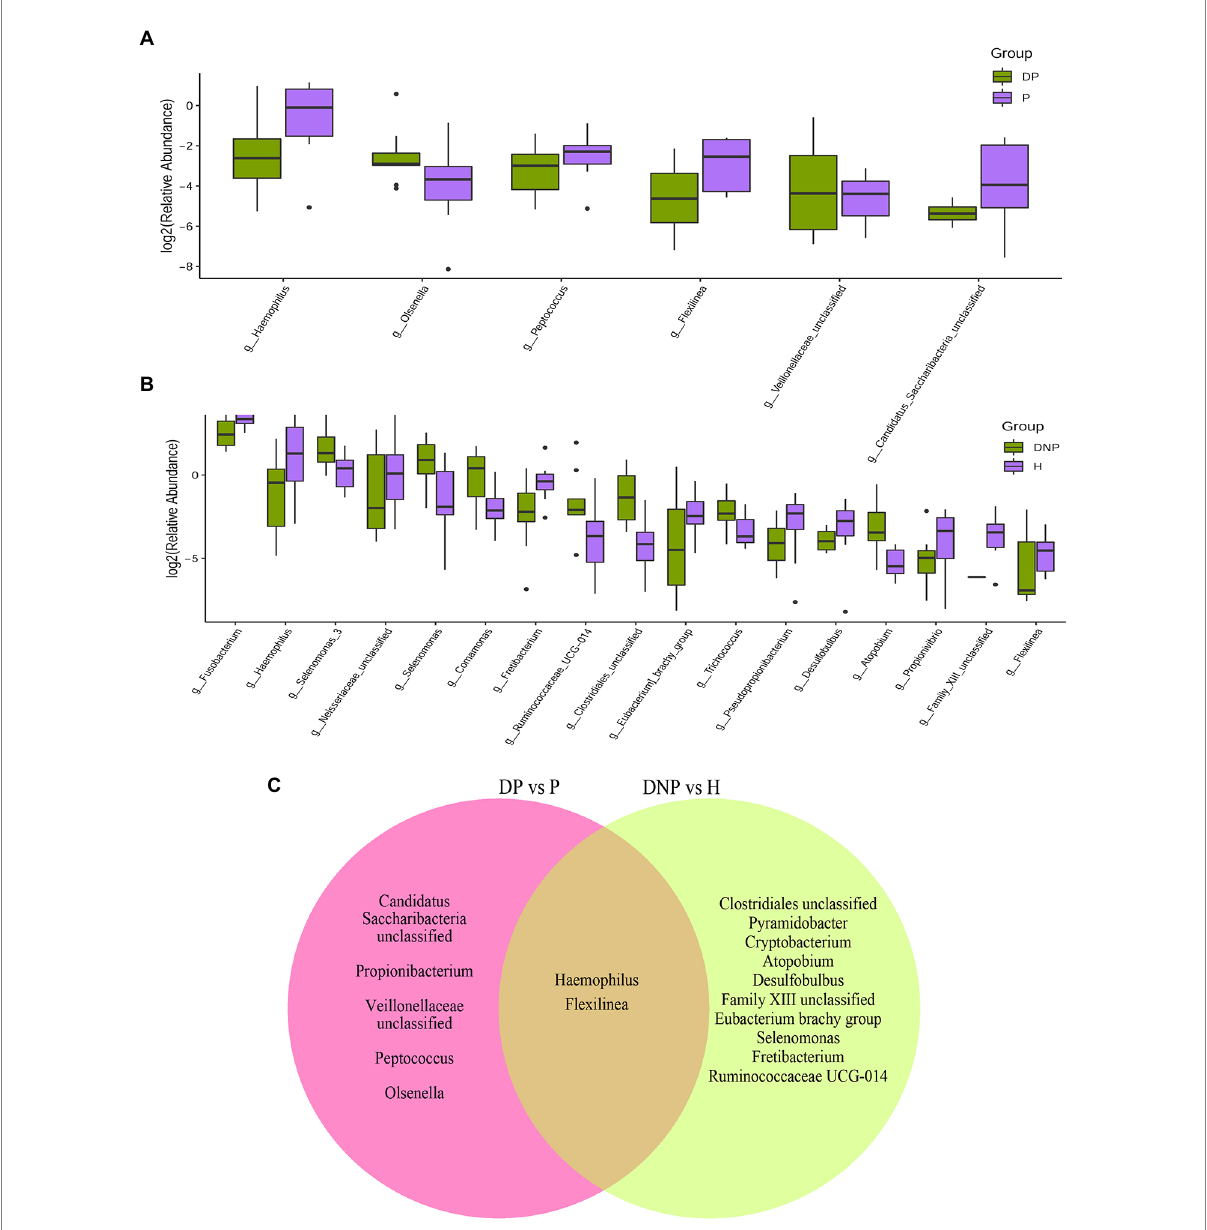
FIGURE 3 Distribution of differential genera between patients with periodontitis with/without T2DM. (A) Difference in relative abundances of subgingival bacterial genera between the DP and P groups; (B) Difference in relative abundances of subgingival bacterial genera between the DNP and H groups; (C) The nine genera significantly more abundant in the DP vs. P groups; 7 genera significantly more abundant in the DNP than H